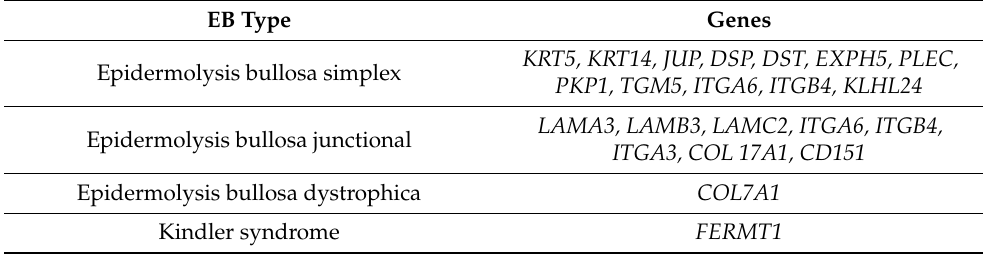
Table 1. Genes involved in different types of